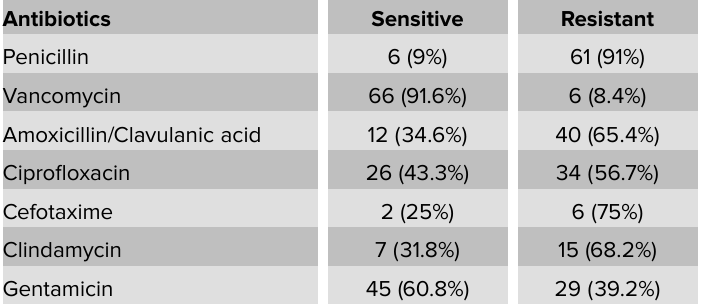
Table 4: Frequencies of antibiotic susceptibility of the gram-positive